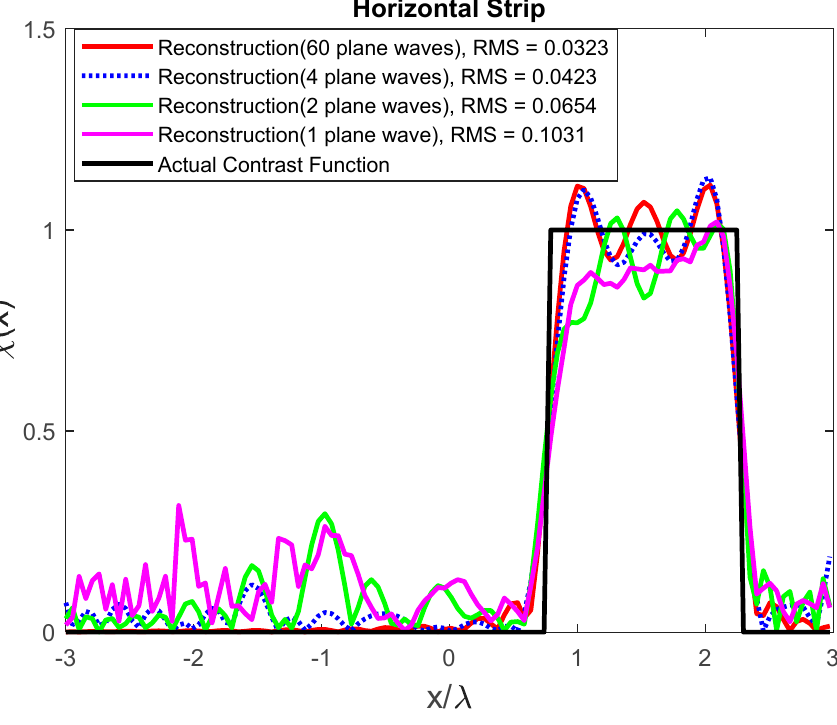
Figure 14. The reconstructions of a horizontal strip within the cross-strip ID, for different numbers of impinging plane waves.